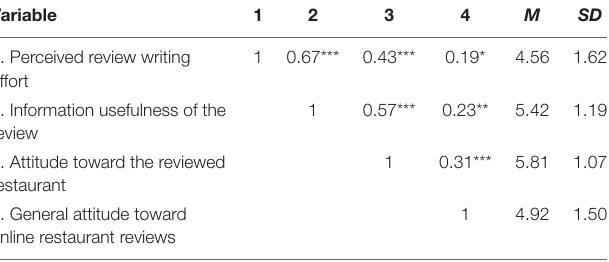
TABLE 1 | Zero-order correlations, means, and standard deviations.